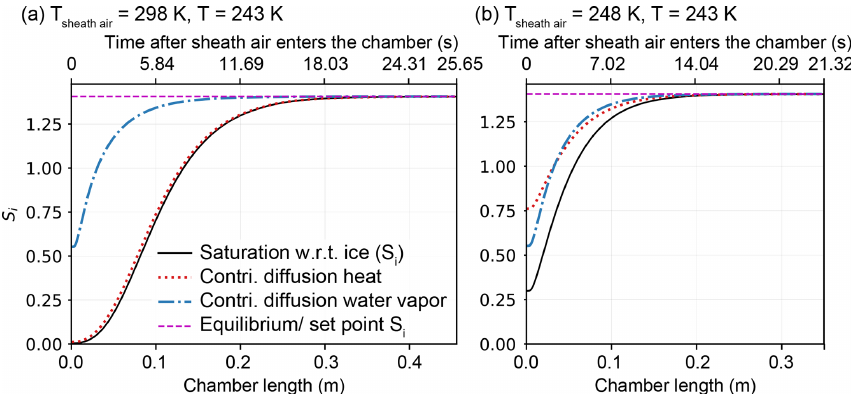
Figure 4. Simulated ice supersaturation development along the chamber’s center lamina at T = 243K and contributing factors diffusion of heat and water vapor for (a) T sheath air = 298K (original length) and (b) T sheath air = 248K (allowing for the chamber length to be reduced by